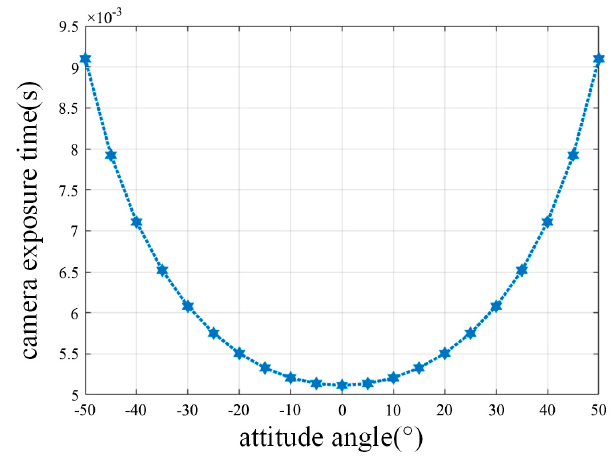
Figure 8. Camera exposure function.